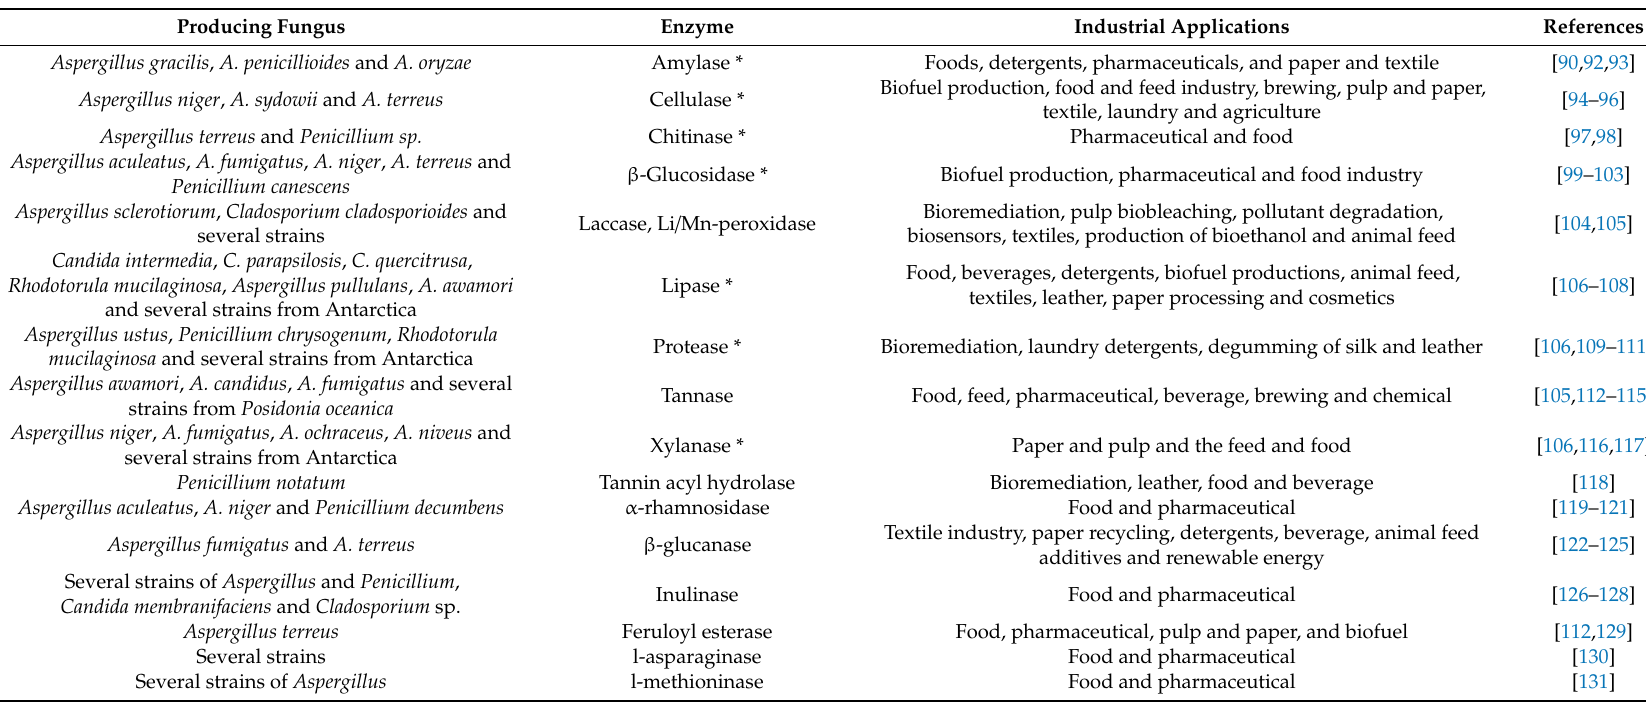
Table 2. Examples of enzymes produced by fungi genera found in DHABs, and their industrial applications. Stars indicate enzymes exploited as extremozymes. Producing Fungus Enzyme Industrial Applications Aspergillus gracilis , A. penicillioides and A. oryzae Amylase